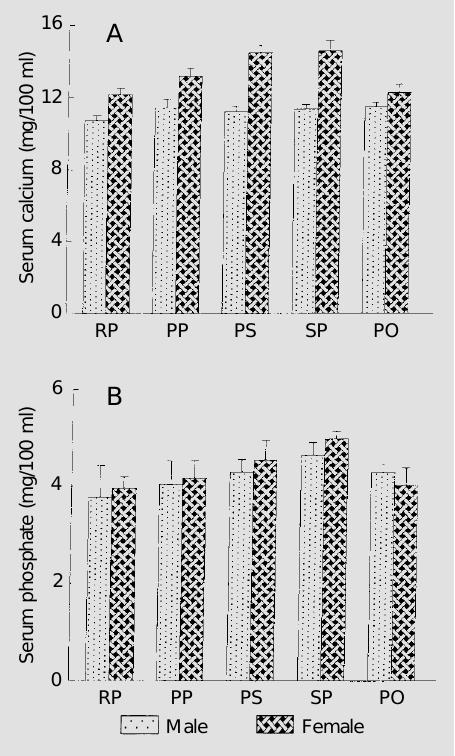
Figure 2 - Serum calcium (A) and phosphate (B) levels of male and female Channa punctatus during different reproductive phases. Each value represents the mean ± SD of ten specimens. RP = Resting phase; PP = preparatory phase; PS = prespawning phase; SP = spawning phase; PO = postspawning